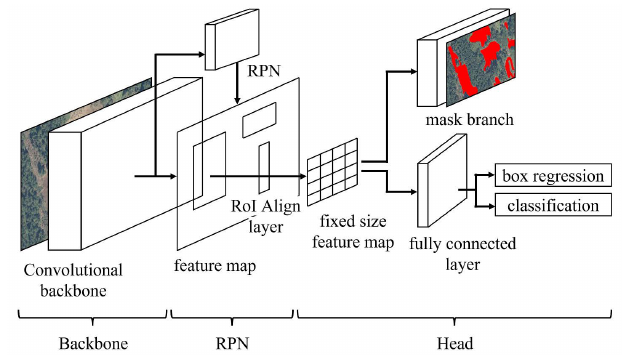
Figure 1. Mask R-CNN